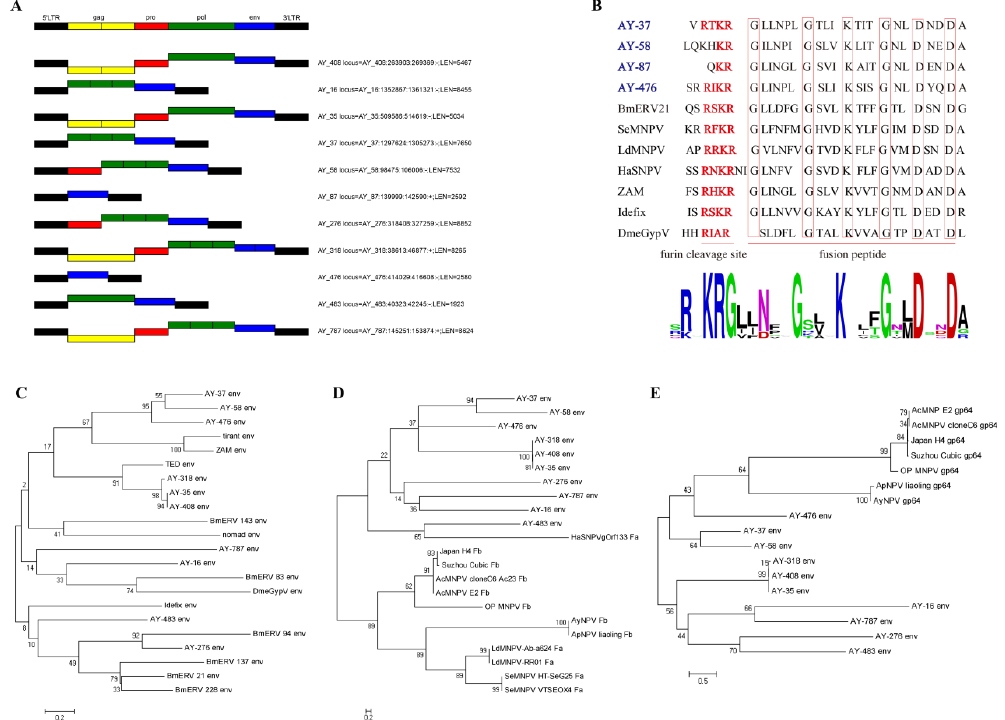
Figure 2. Analysis of the AyLTRs env genes. ( A ) Structure of AyLTRs which contained the env element. ( B ) Multiple alignment of the conserved amino acid sequence block shows a consensus furin cleavage site RxxR and the peptide fusion consensus sequence in the envelope proteins of AY-37, AY-58, AY-87, AY-476, BmERV21, ZAM, Idefix, DmeGypV, and the F protein of SeMNPV, LdMNPV and HaSNPV. Logo visualization of the furin cleavage site and peptide fusion consensus sequence was performed using WEBLOGO (weblogo.berkeley.edu/logo.cgi). ( C ) Phylogenetic analysis of the env gene of AyLTRs and known insect LTR retrotransposons. ( D ) Phylogenetic analysis of the env gene of AyLTRs and F genes from Group I NPVs (Fb) and Group II NPVs (Fa). ( E ) Phylogenetic analysis of the env gene of AyLTRs and GP64 of Group I NPVs.